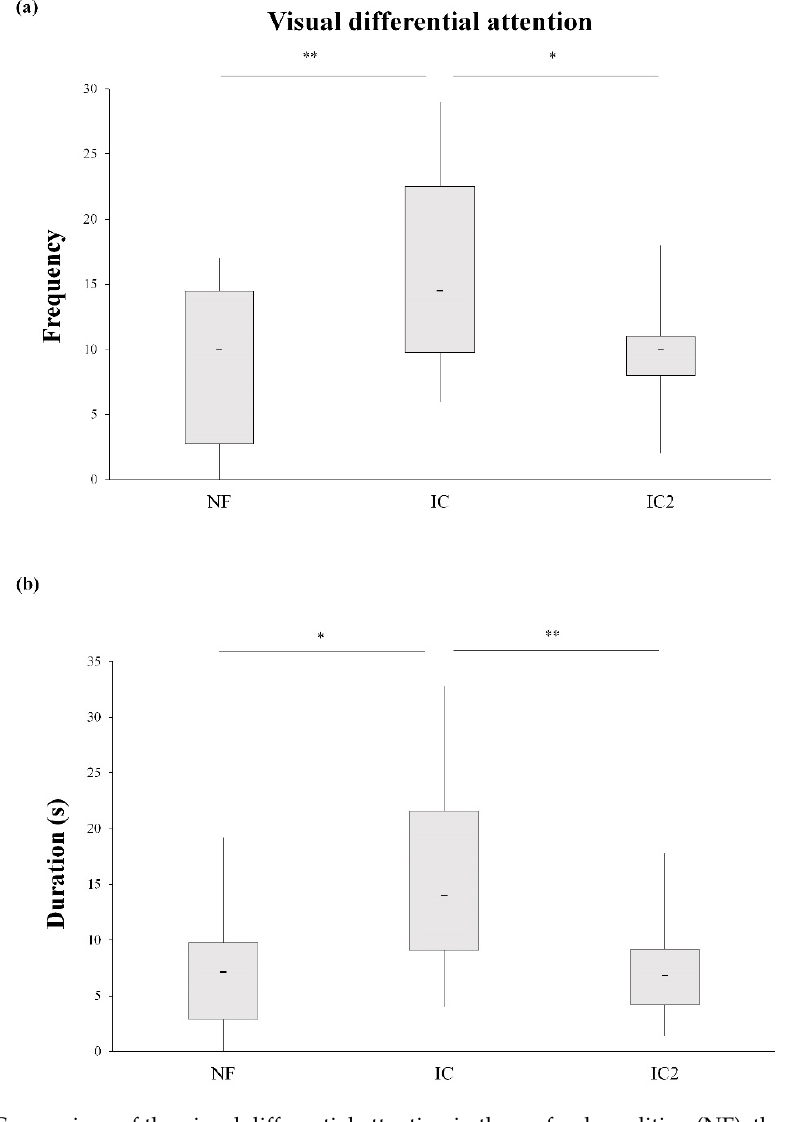
Figure 2. Comparison of the visual differential attention in the no food condition (NF), the impossible condition with humans (IC), and the impossible condition with no humans (IC2) (experiment 2) in frequency ( a ) and duration ( b ). The asterisks indicate statistically significant differences according to repeated-measures Friedman test with Wilcoxon pairwise (Bonferroni corrected) as the post-hoc test. Bold horizontal lines: medians; grey boxes: quartiles; thin vertical lines: minimum and maximum values. * p < 0.05; ** p < 0.001.